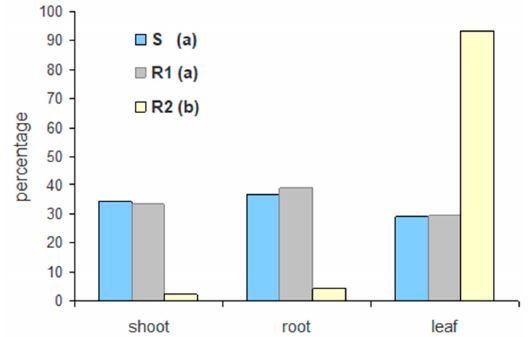
Figure 5. Allocation (%) of 14 C-glyphosate among the remaining shoot, root and the treated leaf 96 HAT in plants of the three C. sumatrensis populations tested. Different letters indicate statistically different allocation patterns according to a